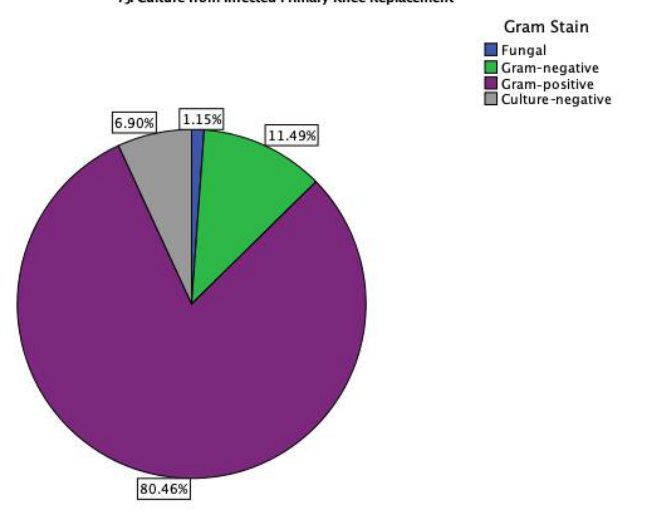
Figure 1. PJI culture results from infected primary TKA.